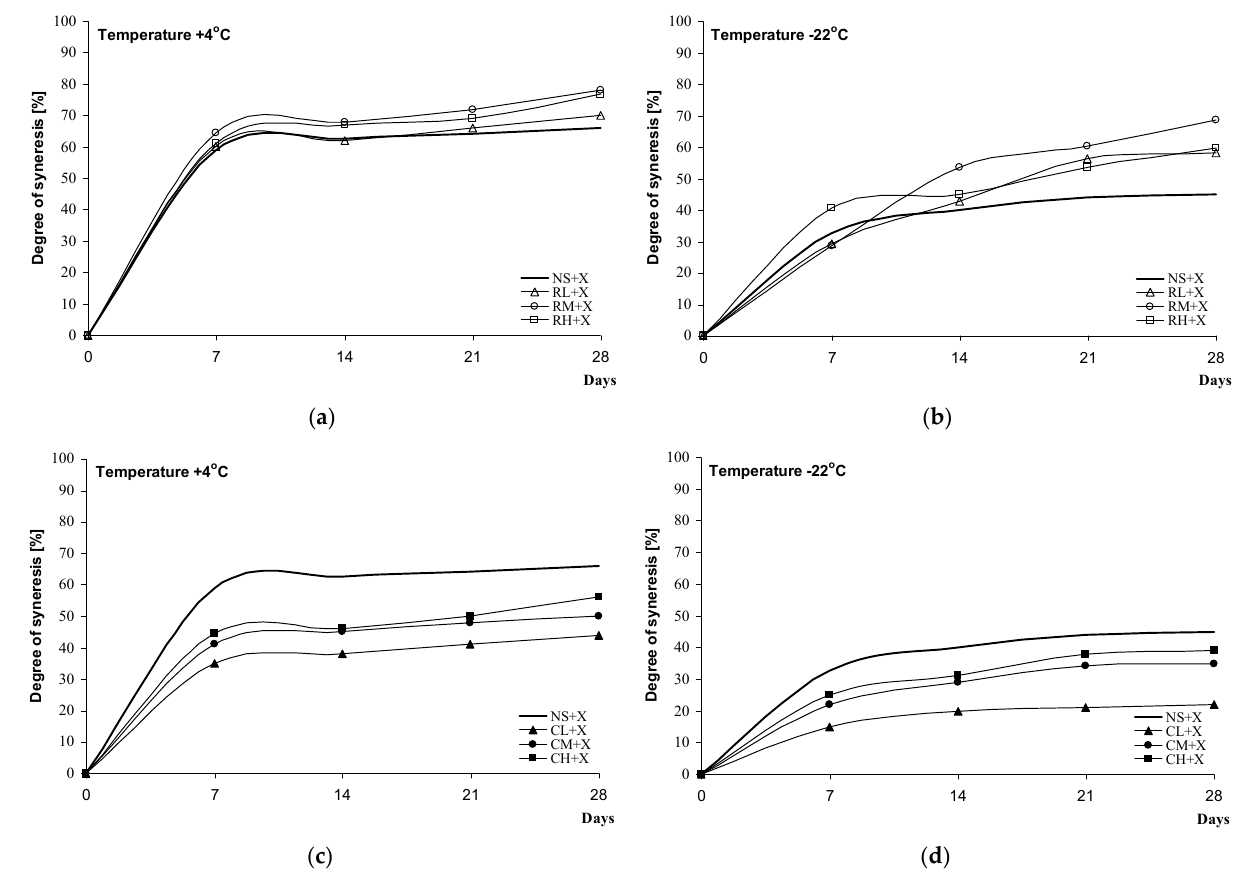
Figure 6. Syneresis of black jelly ‐ like desserts prepared on the basis of chemically ( a , b ) or physi ‐ cally ( c , d ) modified starches sweetened with sucrose.